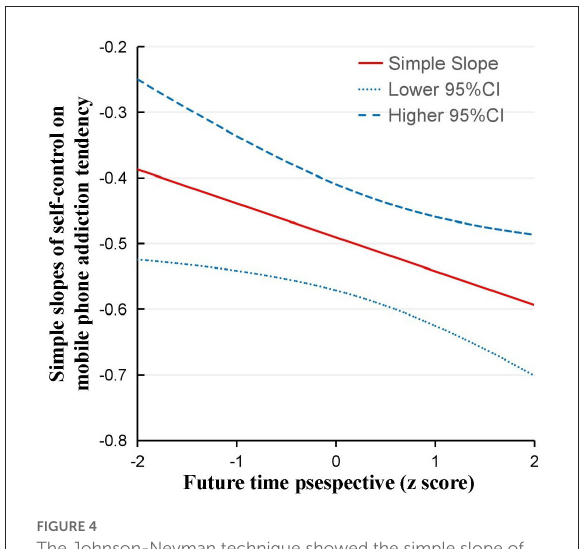
FIGURE4 The Johnson-Neyman technique showed the simple slope of self-control on the mobile phone addiction tendency. Dotted lines represent upper and lower 95% CIs of the simple slope. A high future time perspective combined with high self-control predicted a low level of mobile phone addiction